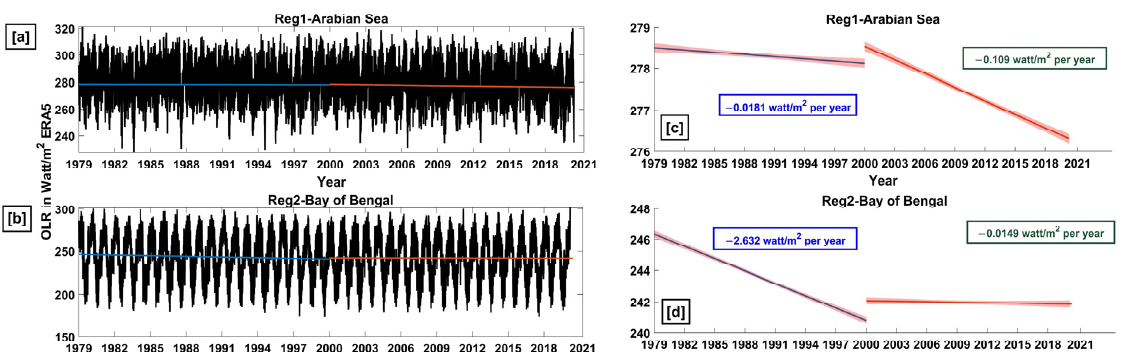
Figure 5. Trend of Outgoing Longwave Radiation (W m − 2 ) along with the corresponding confidence interval (red patches) over the ( a ) Arabian Sea and ( b ) Bay of Bengal region during 1979–2020. The magnified view of the OLR trends on a two decadal scale are shown in ( c ) for Arabian Sea, and ( d ) for Bay of Bengal.